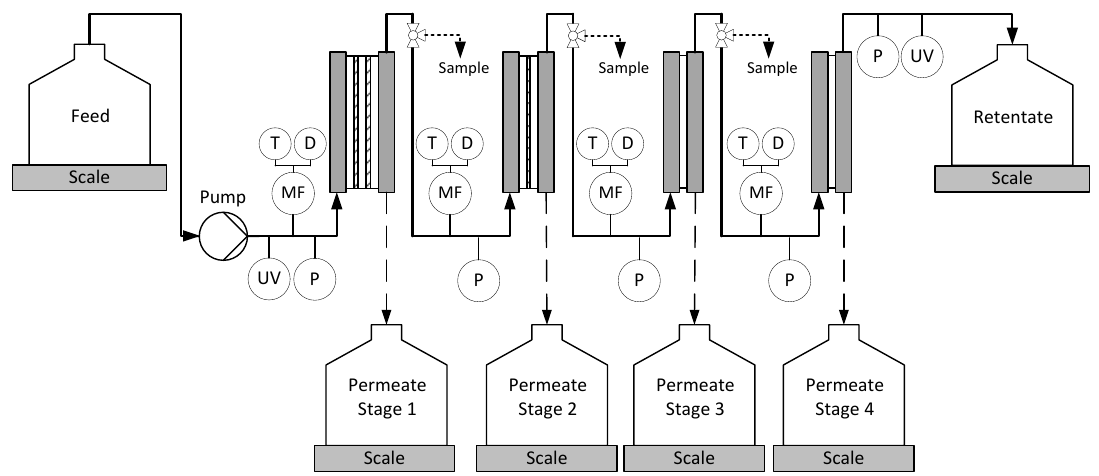
Figure 5. Experimental setup for model validation of four-in-series.